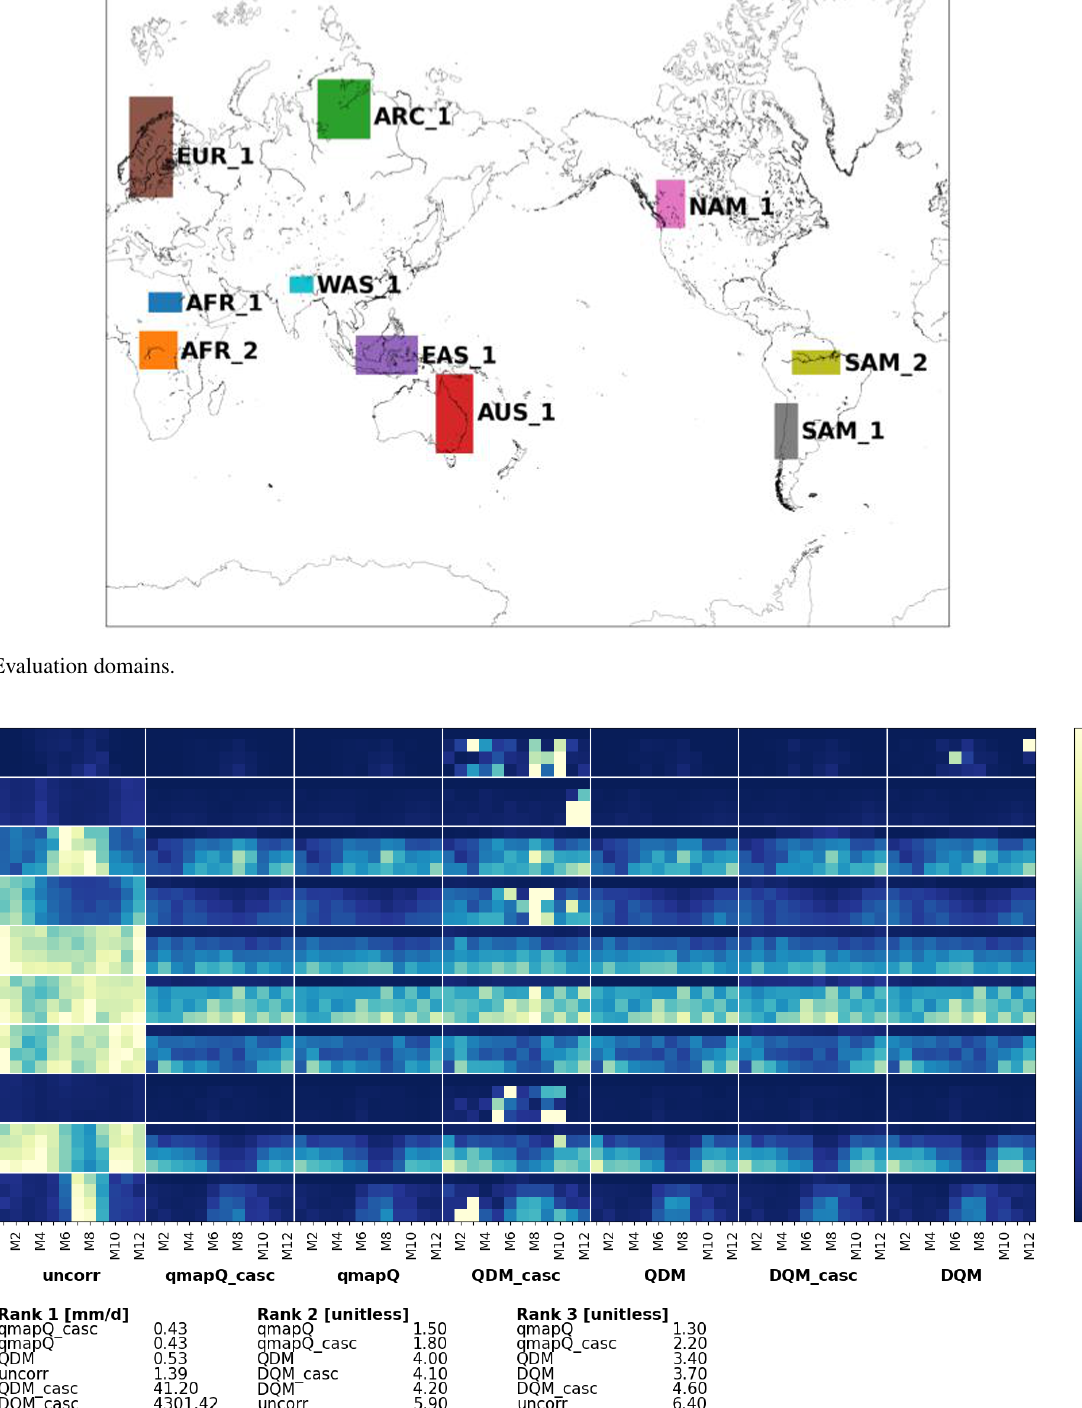
Geosci. Model Dev., 15, 6165–6180,